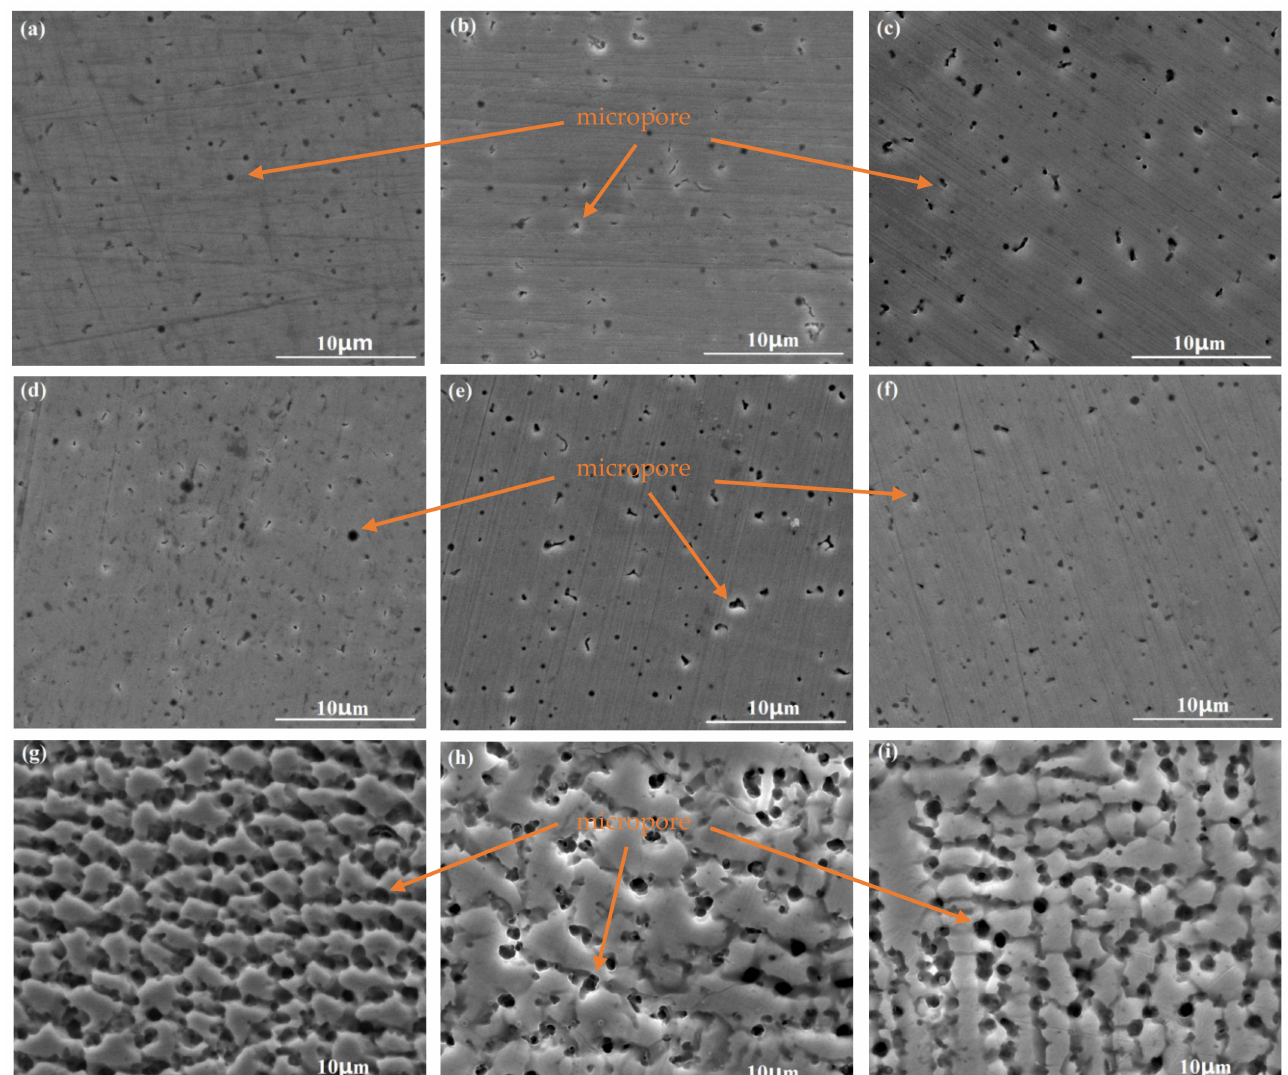
Figure 13. Corroded morphologies of the C22 coating after potentiostatic polarization at 100 mV